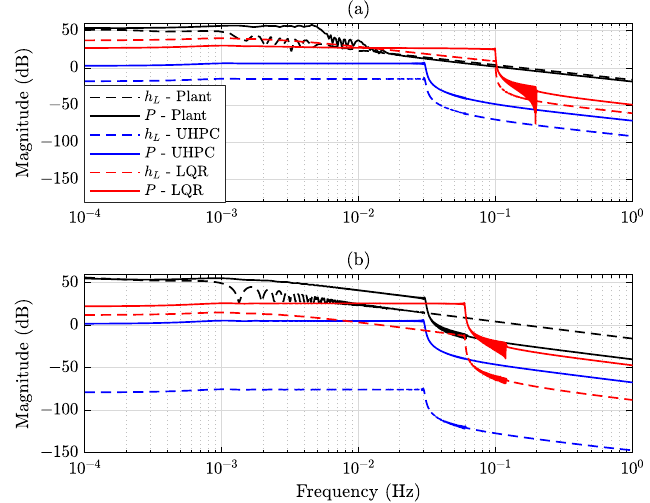
Figure 8. Frequency response of open- and closed-loop systems ( a ) with L in as input and ( b ) with G in as